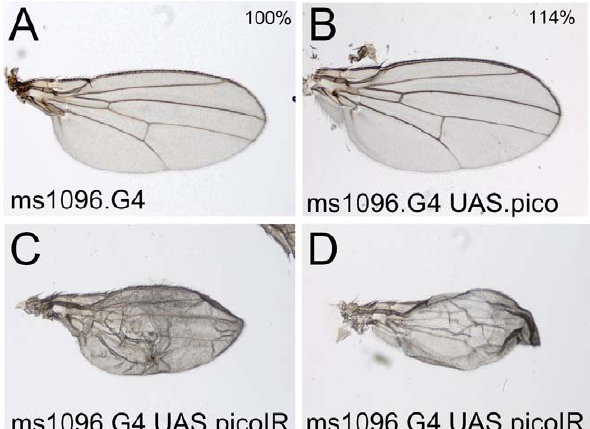
Figure 4. Pico is required for morphogenesis in the wing and can drive overgrowth when overexpressed. ( A ) A control ms1096.Gal4 wing. ( B ) Overexpression of Pico with ms1096.Gal4 drives overgrowth, similar to overexpression of Mal. ( C,D ) RNAi knockdown of Pico with ms1096.Gal4 causes blisters (C) or crumpling (D) but does not strongly reduce wing